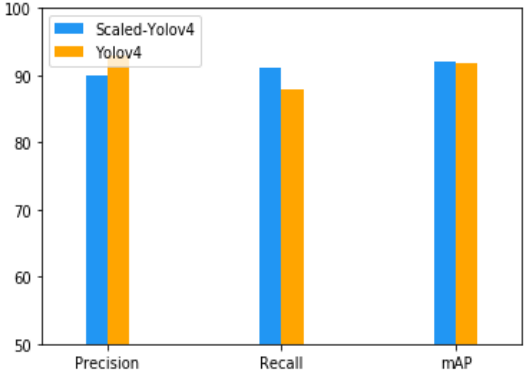
Figure 12. Comparison of Scaled-YOLOv4 vs. YOLOv4.